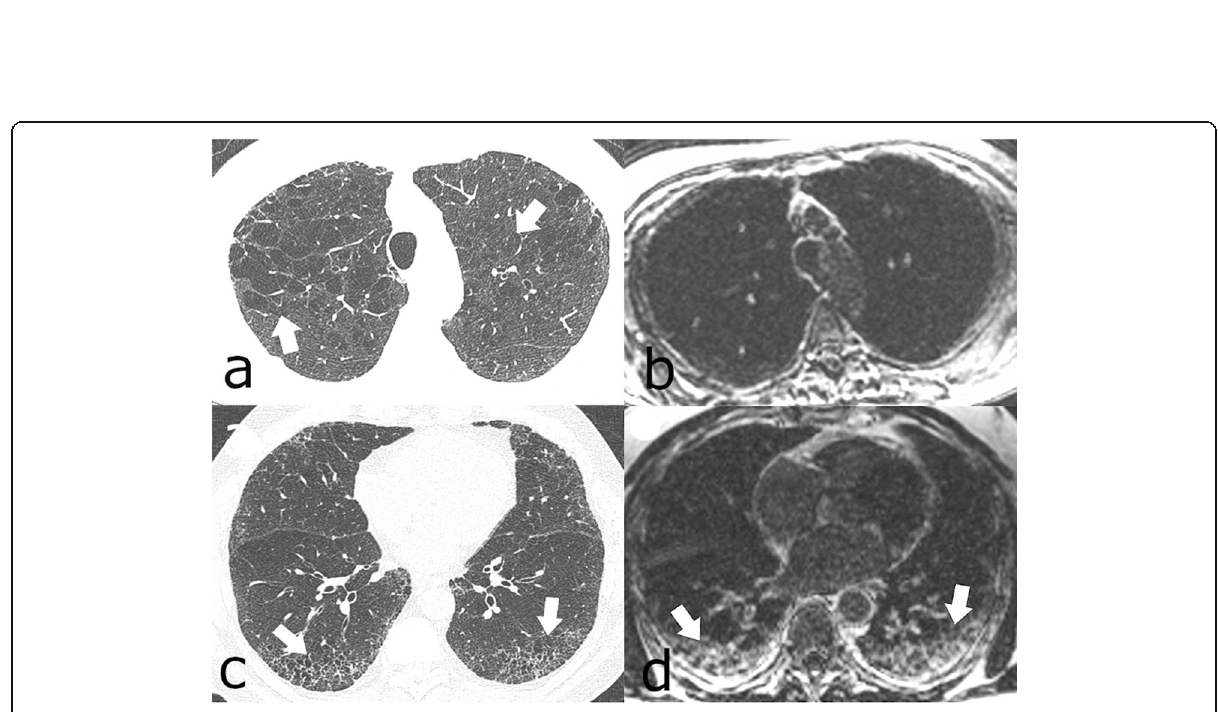
Fig. 3 Fifty-seven-year-old man with progressive breathlessness, FEV 1 2.4L/s, LAV 7.6%. a Axial high-resolution computed tomography showed moderate centrilobular emphysema in the upper lobes (arrows). b It was unclear at multidisciplinary conference whether the abnormal regions in the lower lobes (arrows) represented emphysema or fibrosis. c Late gadolinium-enhanced magnetic resonance imaging of the upper lobes showed no contrast enhancement, but in d , definite contrast enhancement in the abnormal regions in the lower lobes (arrows) was consistent with fibrosis. FEV 1 , Forced expiratory volume in one second; LAV% , Low attenuation value